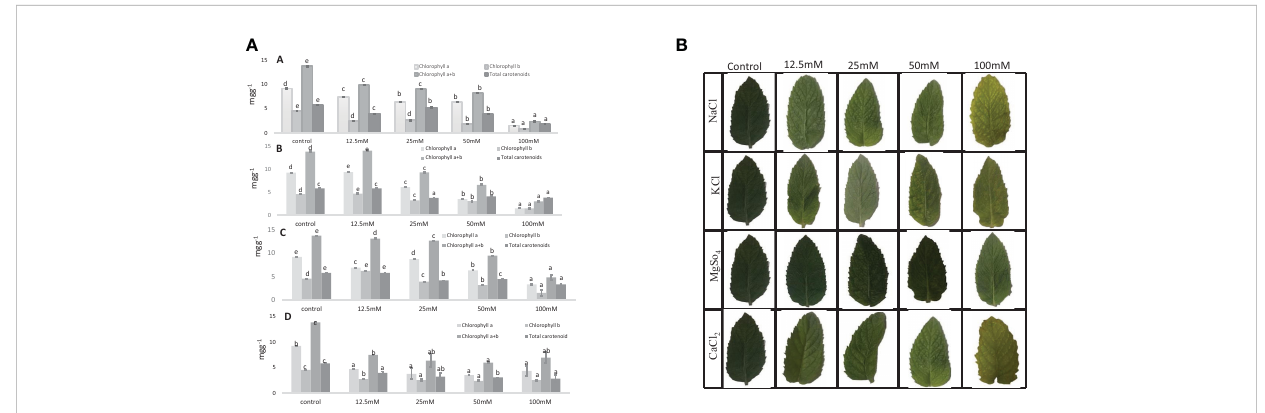
FIGURE 5 1. Chlorophyll content and total carotenoid content (mg g − 1 ) in an M. longifolia leaf sample under salt stress condition. (A) Different concentrations of NaCl; (B) Different concentrations of KCl; (C) Different concentrations of MgSO 4 ; and (D) Different concentrations of CaCl 2 . The data are represented as mean ± standard deviation (n = 3). The different letters on the same color bar show the signi fi cantly different groups according to the Duncan test ( a = 0.05). 2. Photosynthetic pigment in an M. longifolia leaf sample under different salt stress conditions.